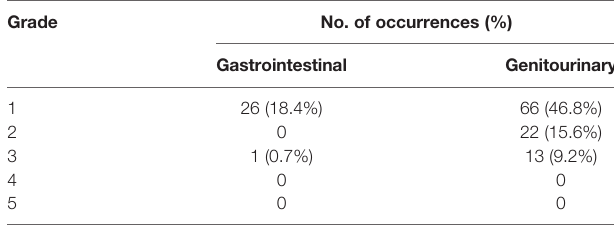
TABLE 2 | Acute toxicity results.